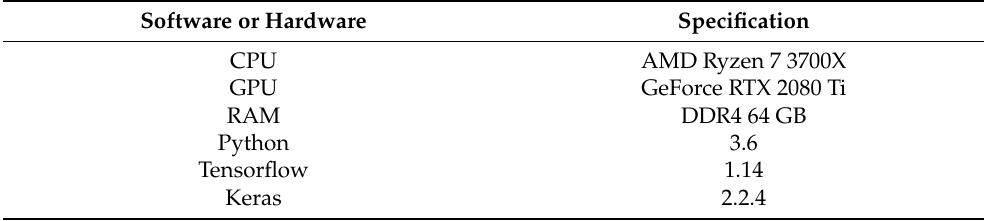
Table 2. Workstation configuration.